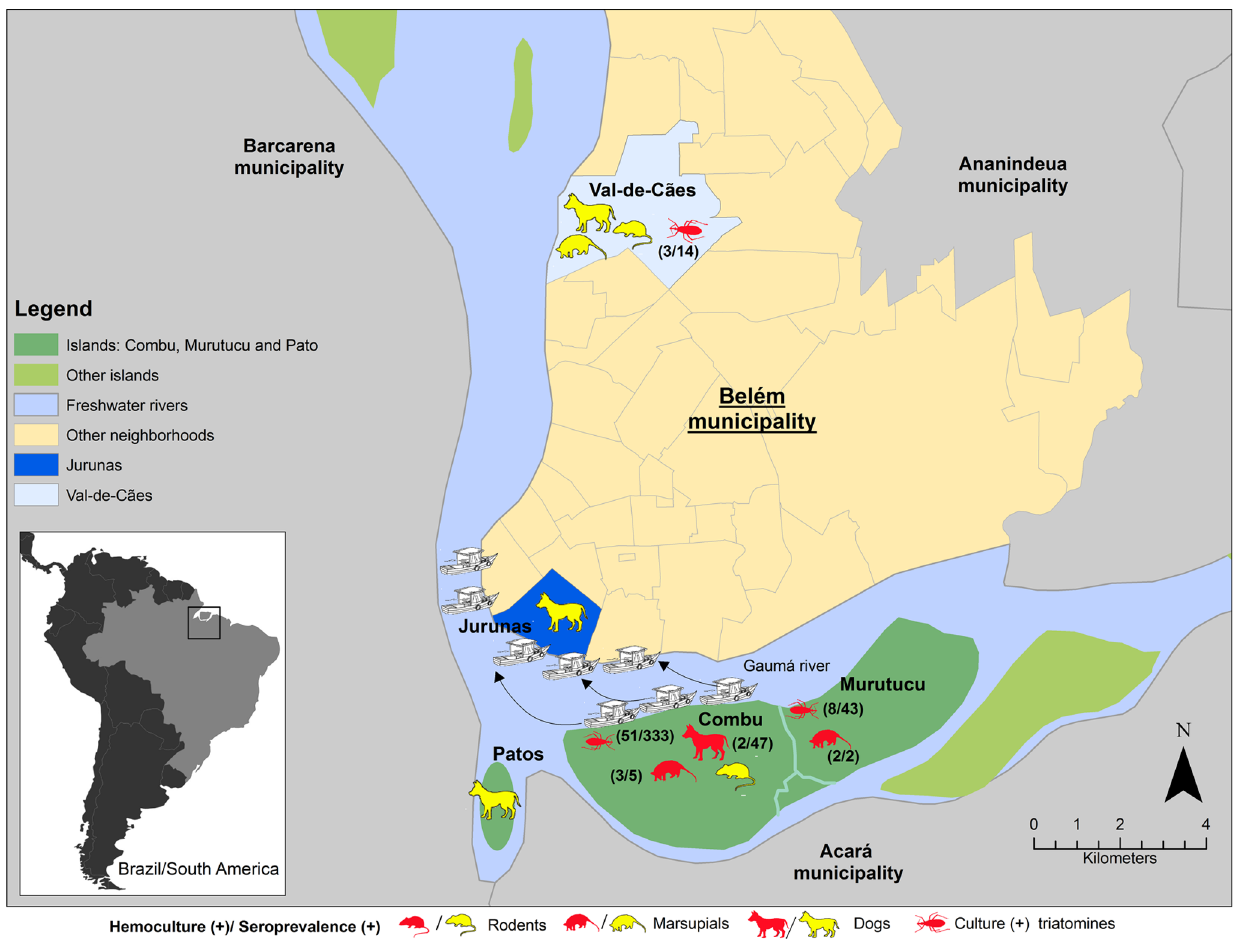
Figure 1. Map of the spatial distribution of the Trypanosomacruzi infections. Mammals and triatomines collected in the Bele´m municipality, in the urban portion (Jurunas and Val-de-Ca˜es) and on the islands (Combu, Murutucu and Pato). The pictures framed in red represent infections animals (positive cultures) among the triatomines, dogs and small mammals examined, and the pictures framed in yellow represent positive serology. On the left of the figure is the study site in Brazil, highlighting Para´ state and the Brazilian and South American borders.